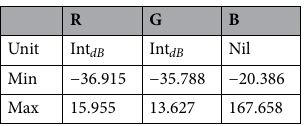
0 values in different bands.